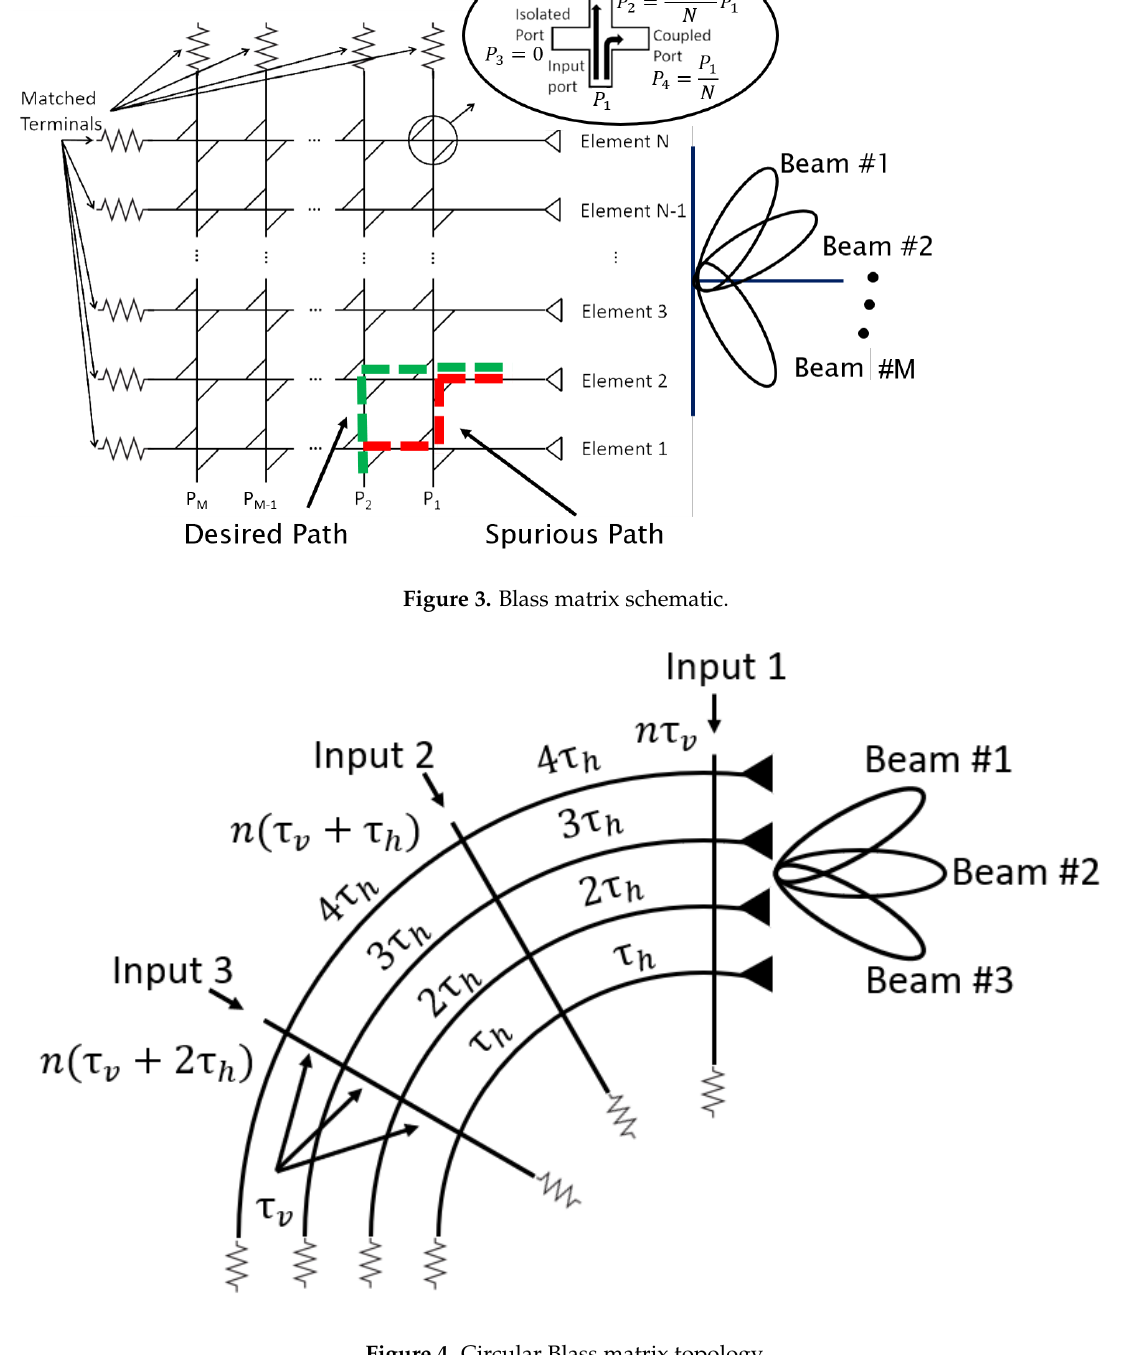
Figure 4. Circular Blass matrix